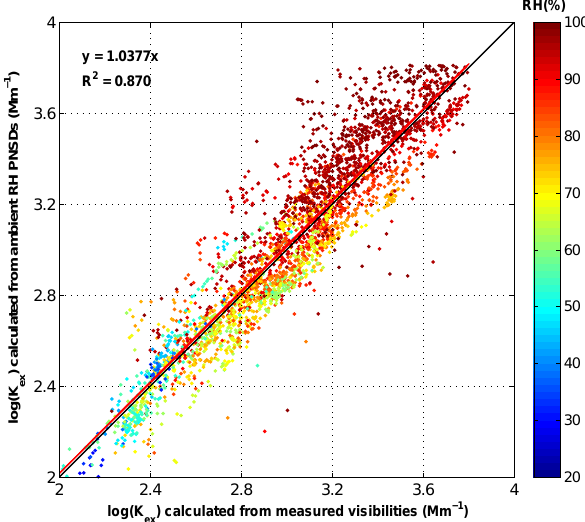
Fig. 3. Comparison of K ex between calculated from ambient RH PNSDs and measured ones at log scale coordinates (log here corre- sponds to log 10 ). Colored dots stand for the corresponding